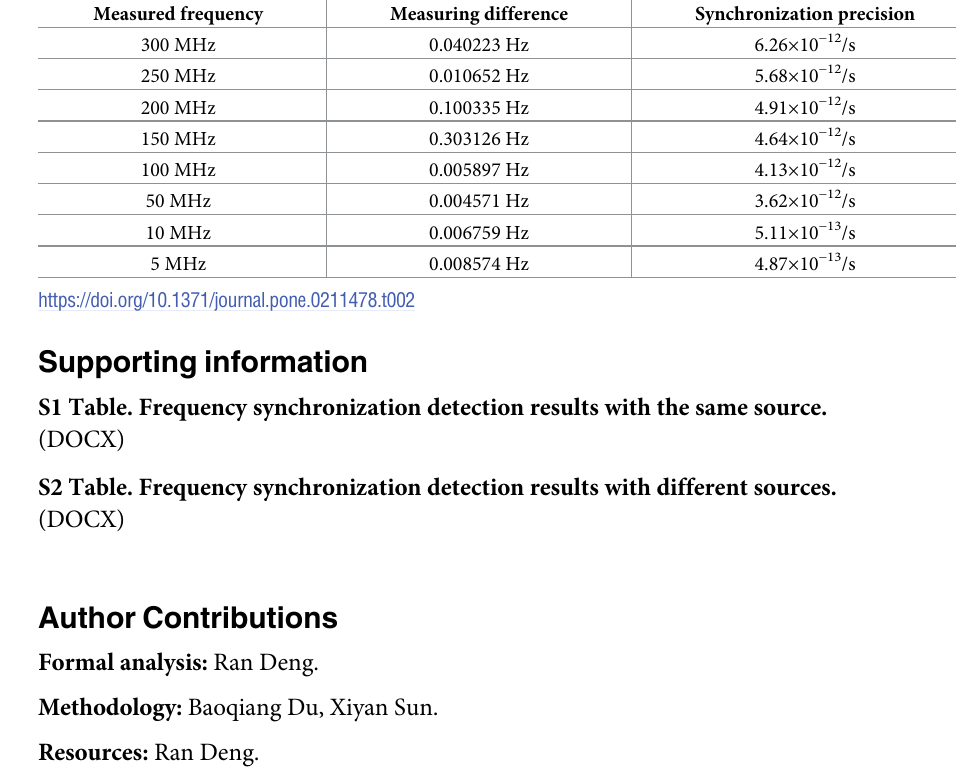
Table 2. Frequency synchronization detection results with different